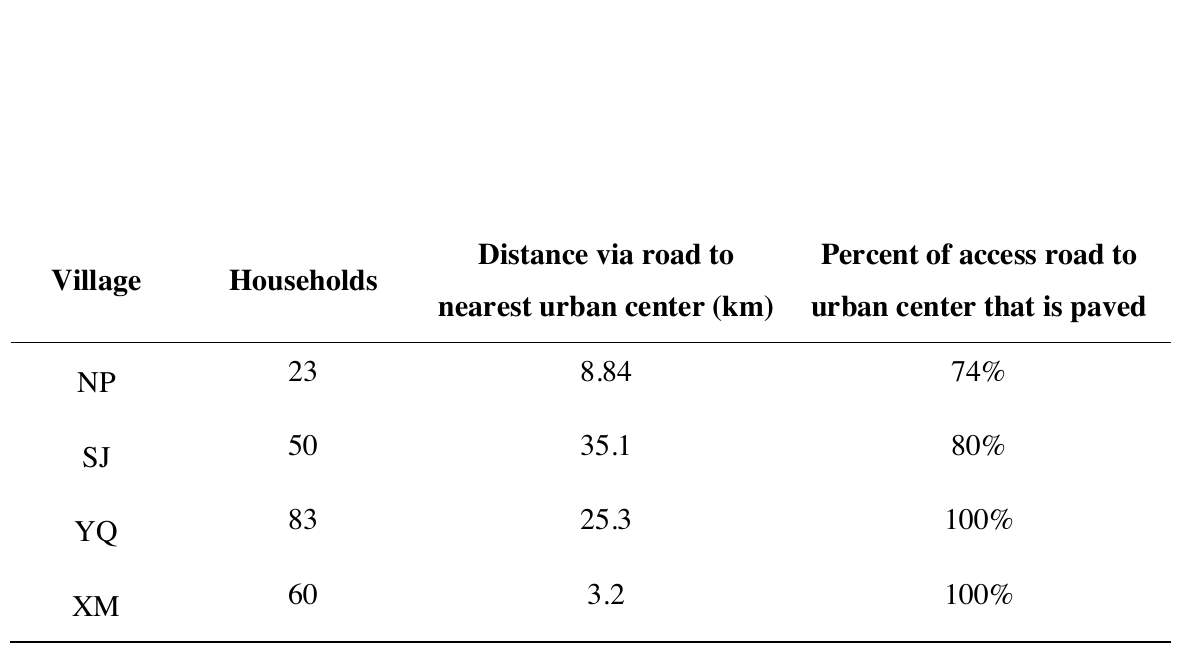
Table A1: The characteristics of the focal villages. The names of the villages are represented using symbols to protect respondent